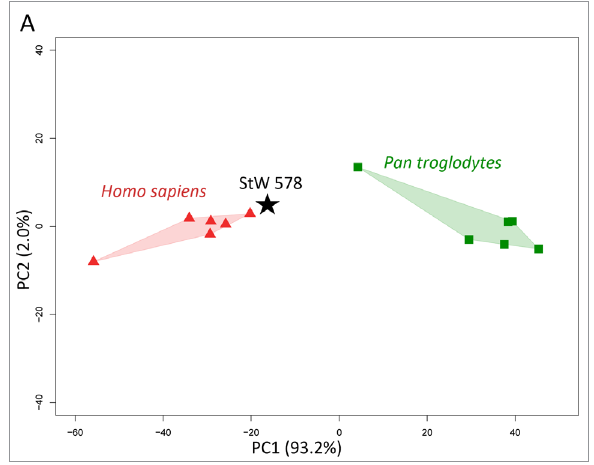
Principal component (PC) analysis of the deformation-based shape comparisons of the unreconstructed upper part of the StW 578 calotte and of the extant human and chimpanzee calottes, focusing on bones originally preserved in StW 578 and artificially isolated in the comparative sample.